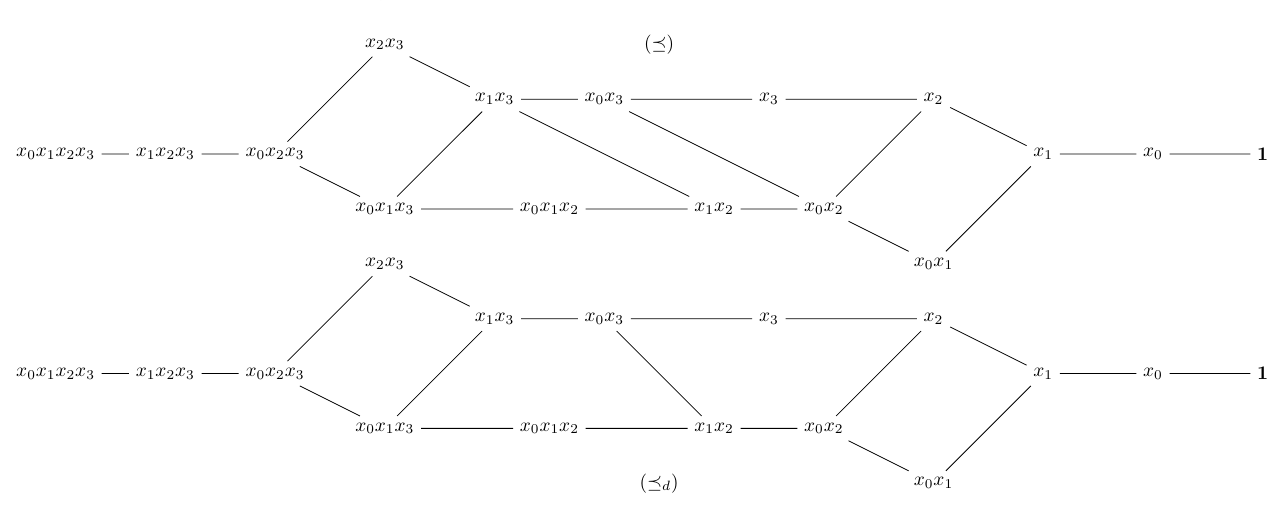
Figure 4. The two-order relations Table 1. Non comparable elements in the middle of